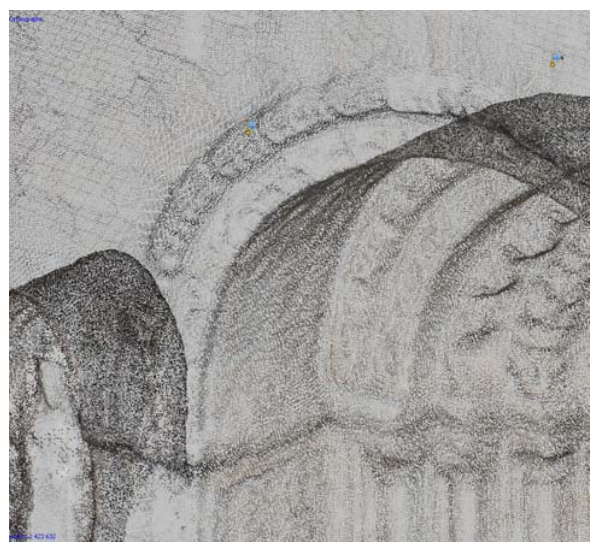
Figure 11. Dense Point Cloud detail in orthographic perspective